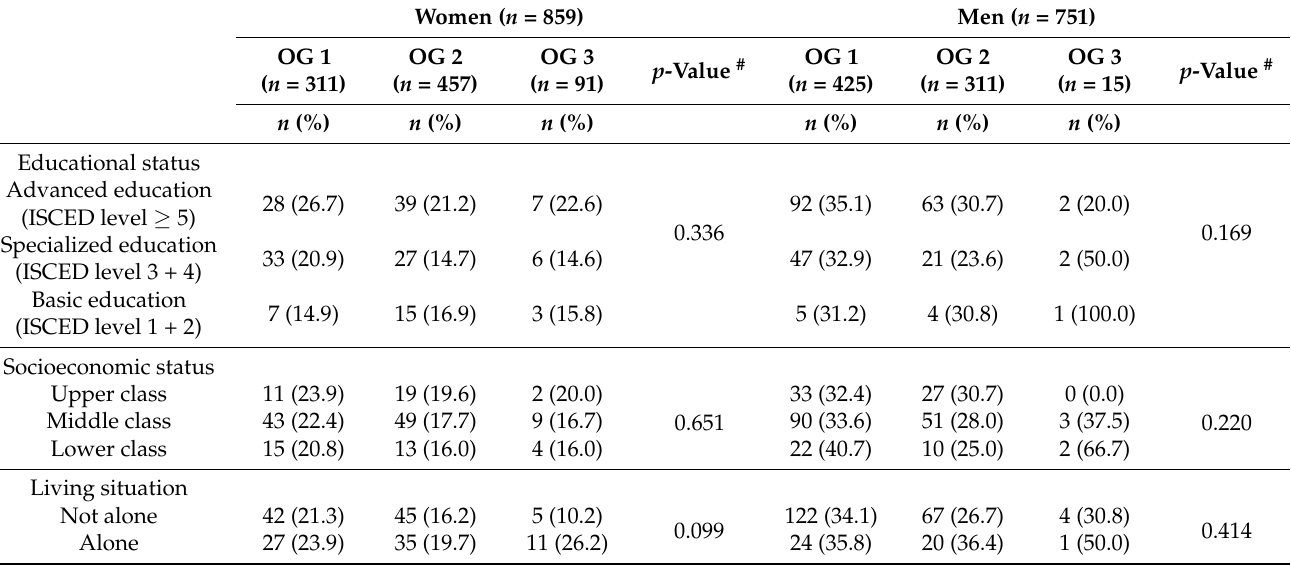
Table 6. Participants with lower adherence to lifestyle recommendations for bone health dependent on their characteristics by sex and osteoporosis